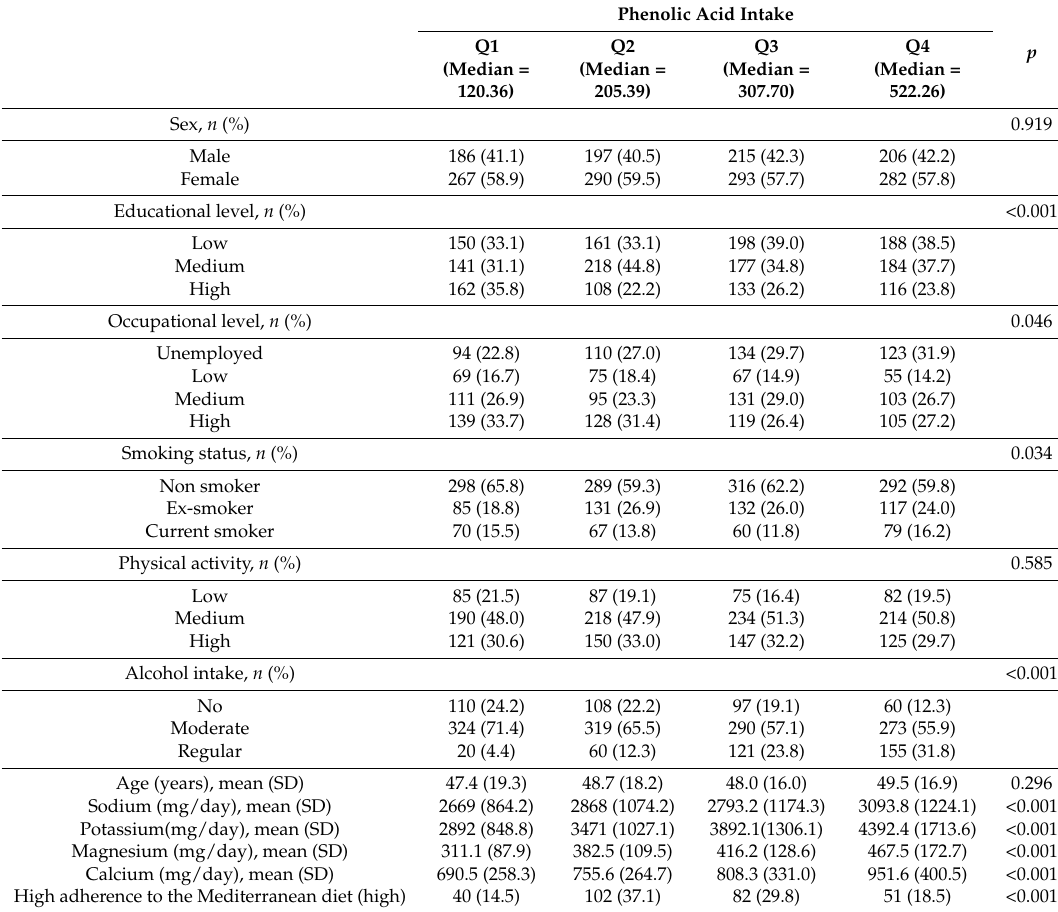
Table 1. Background characteristics by quartiles of dietary phenolic acids in the MEAL study sample ( n = 1936); Q =